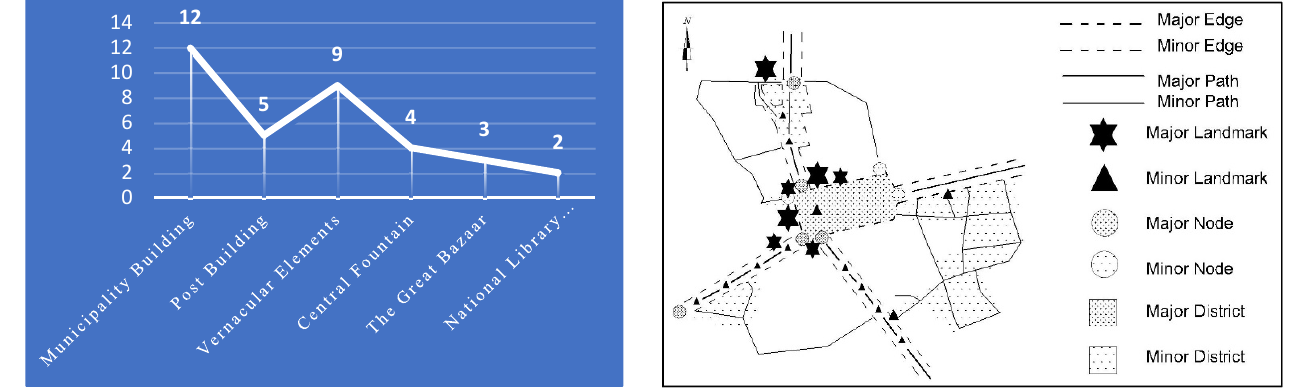
Figure 8. Identifying the most important landmarks based on the frequency of their usage in the hand-drawn sketches made by the participants, and the obtained cognitive map of the participants.